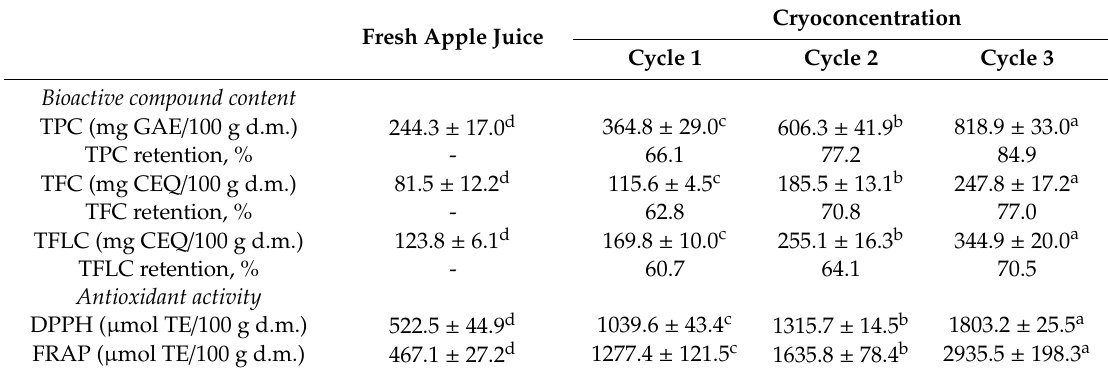
Table 2. Bioactive compounds content and TBC retention (%) of fresh juice and cryoconcentrate samples at each cycle 1